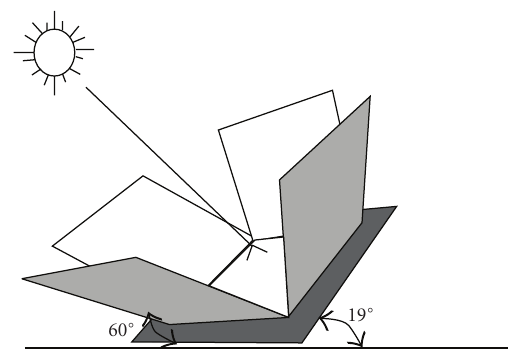
Figure 8: Simple solar collector made from 5 wooden sheets covered with aluminium foil (with permission from [69]).